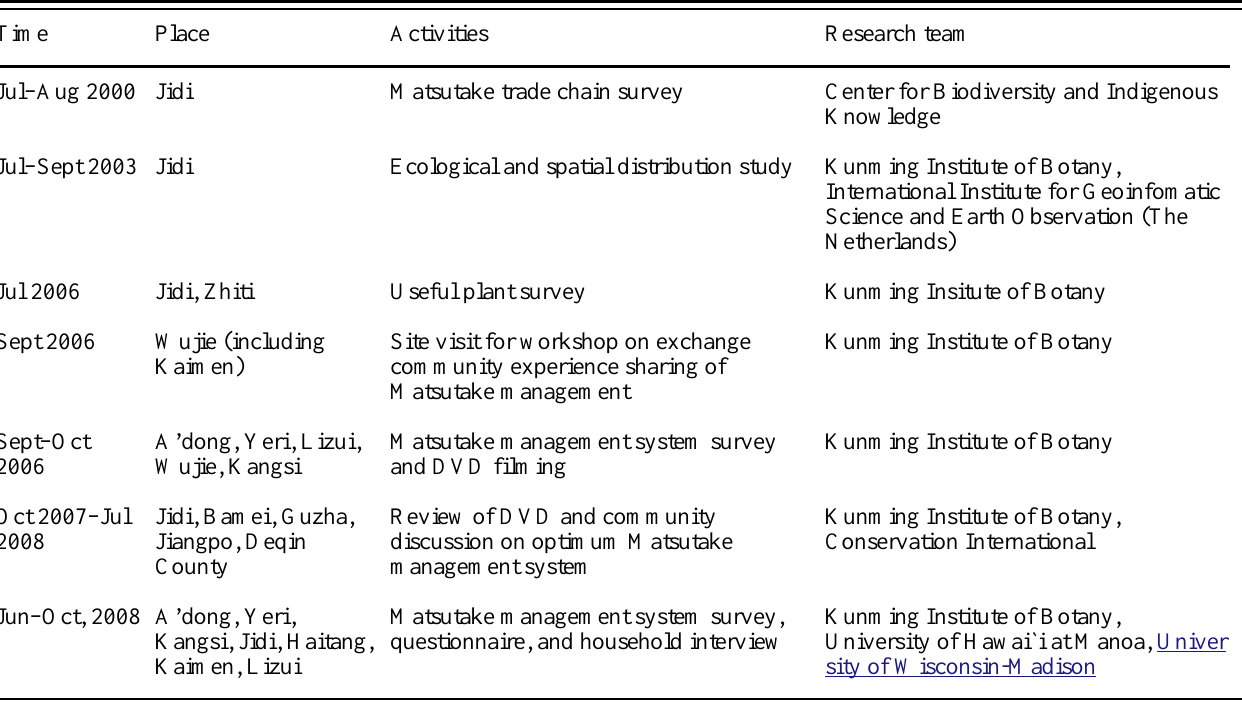
Table 1. Relevant field research on matustake